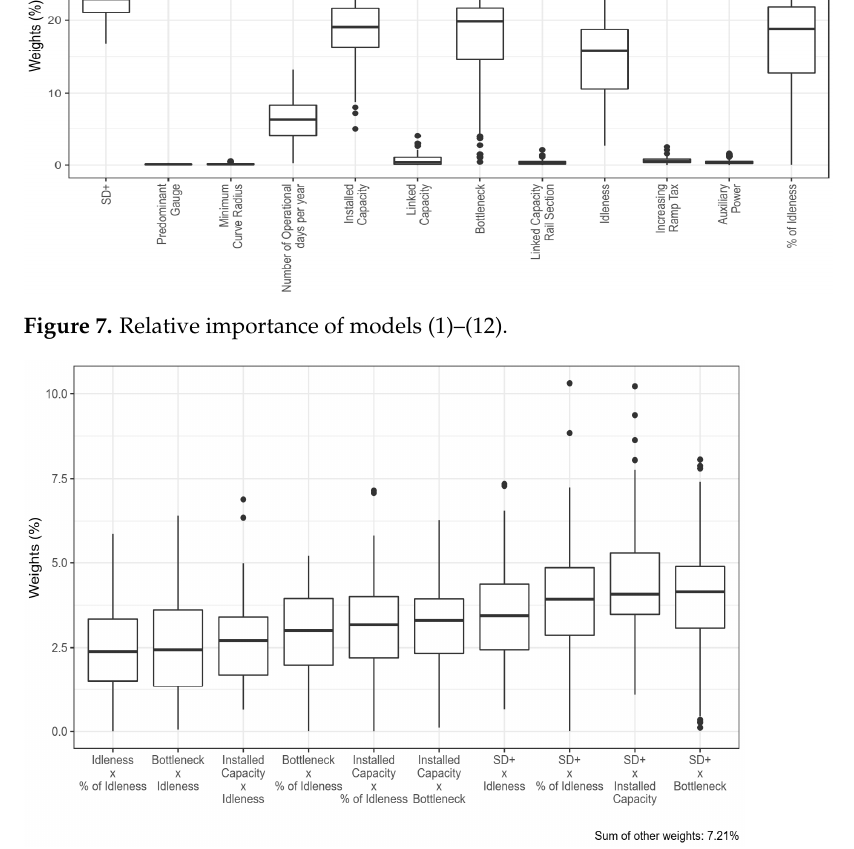
Figure 7. Relative importance of models (1)–(12).